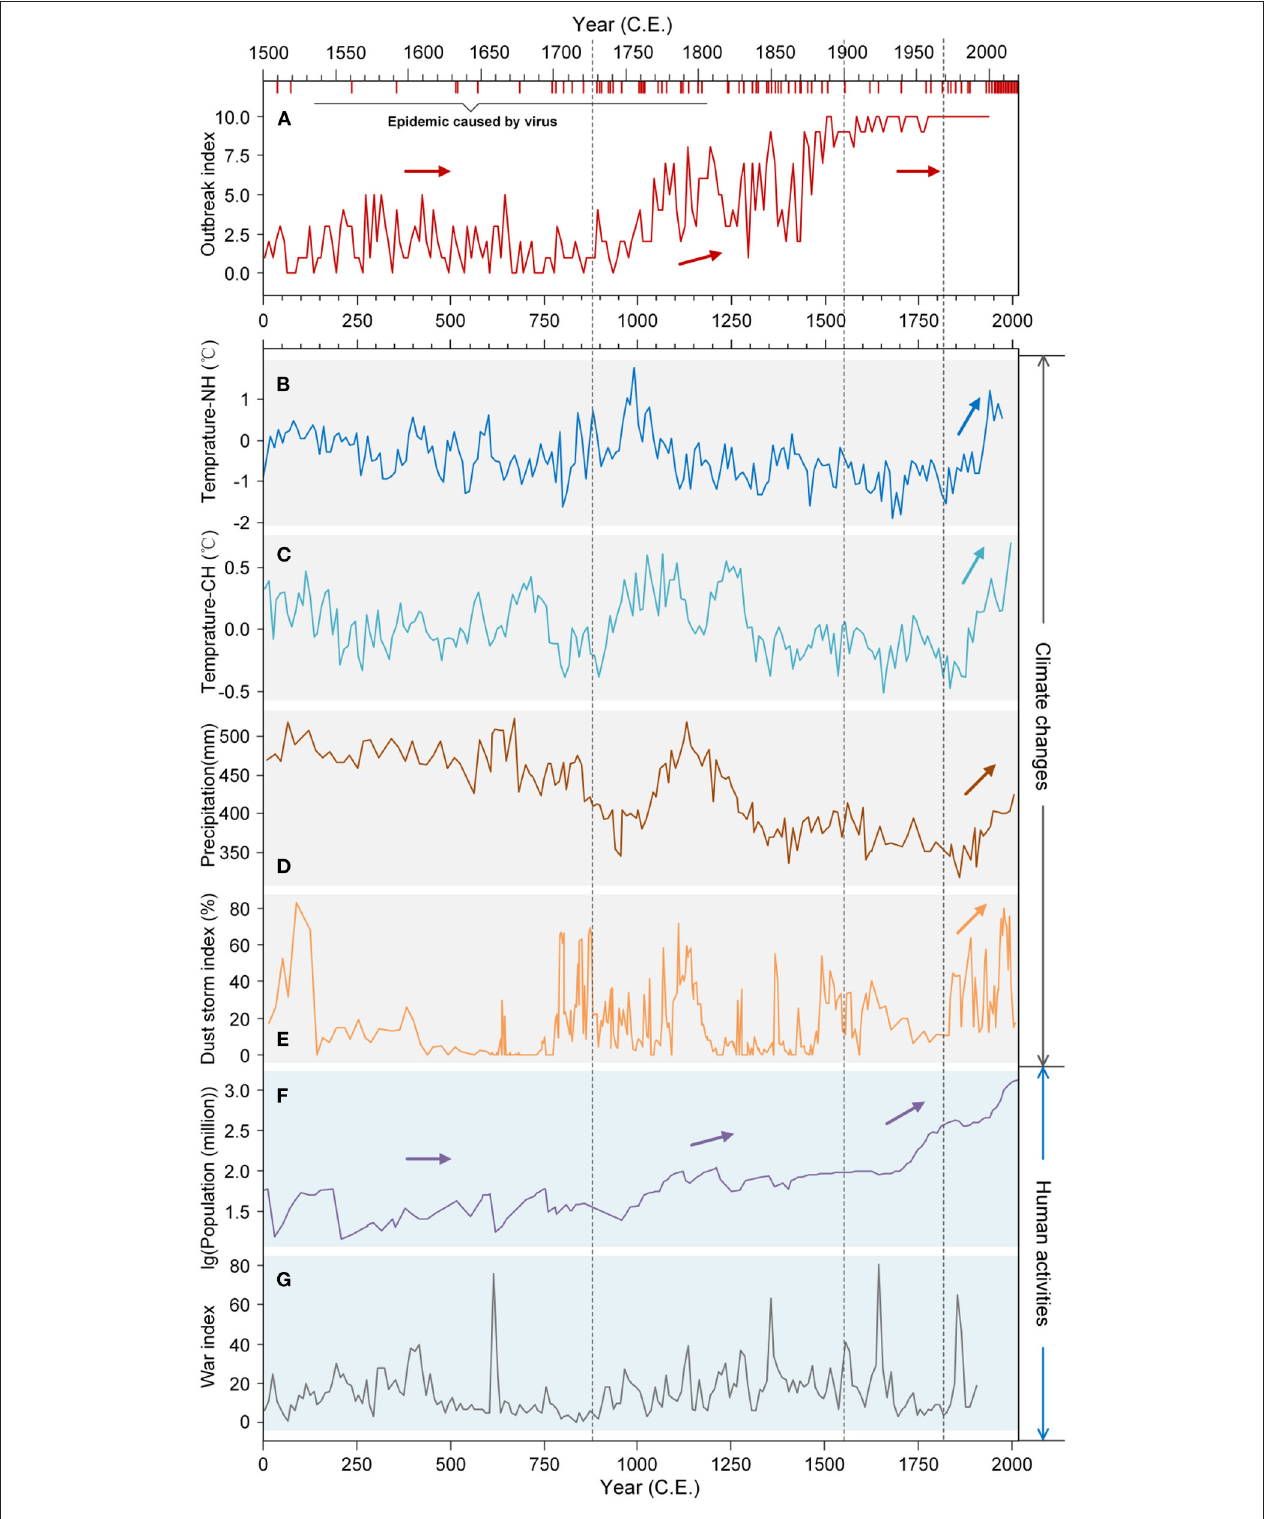
FIGURE 1 | Global trends in climate change and anthropogenic activity and relationships with Chinese epidemic status over the last 2000 years. (A) The epidemic Outbreak Index of China [the number of years epidemics (bacteria, viruses and parasites) were recorded in China], and incidence of major global viral epidemic events. Each red vertical bar represents a viral epidemic event. See Supplementary Table S1 for detailed data information. (B) Temperature in the northern hemisphere